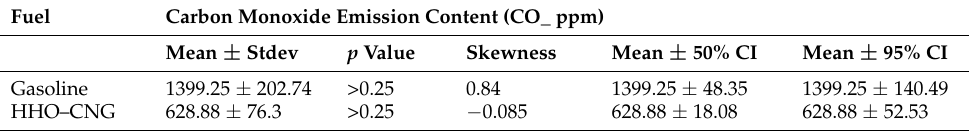
Table 7. Average CO emission contents for 50% and 95% confidence